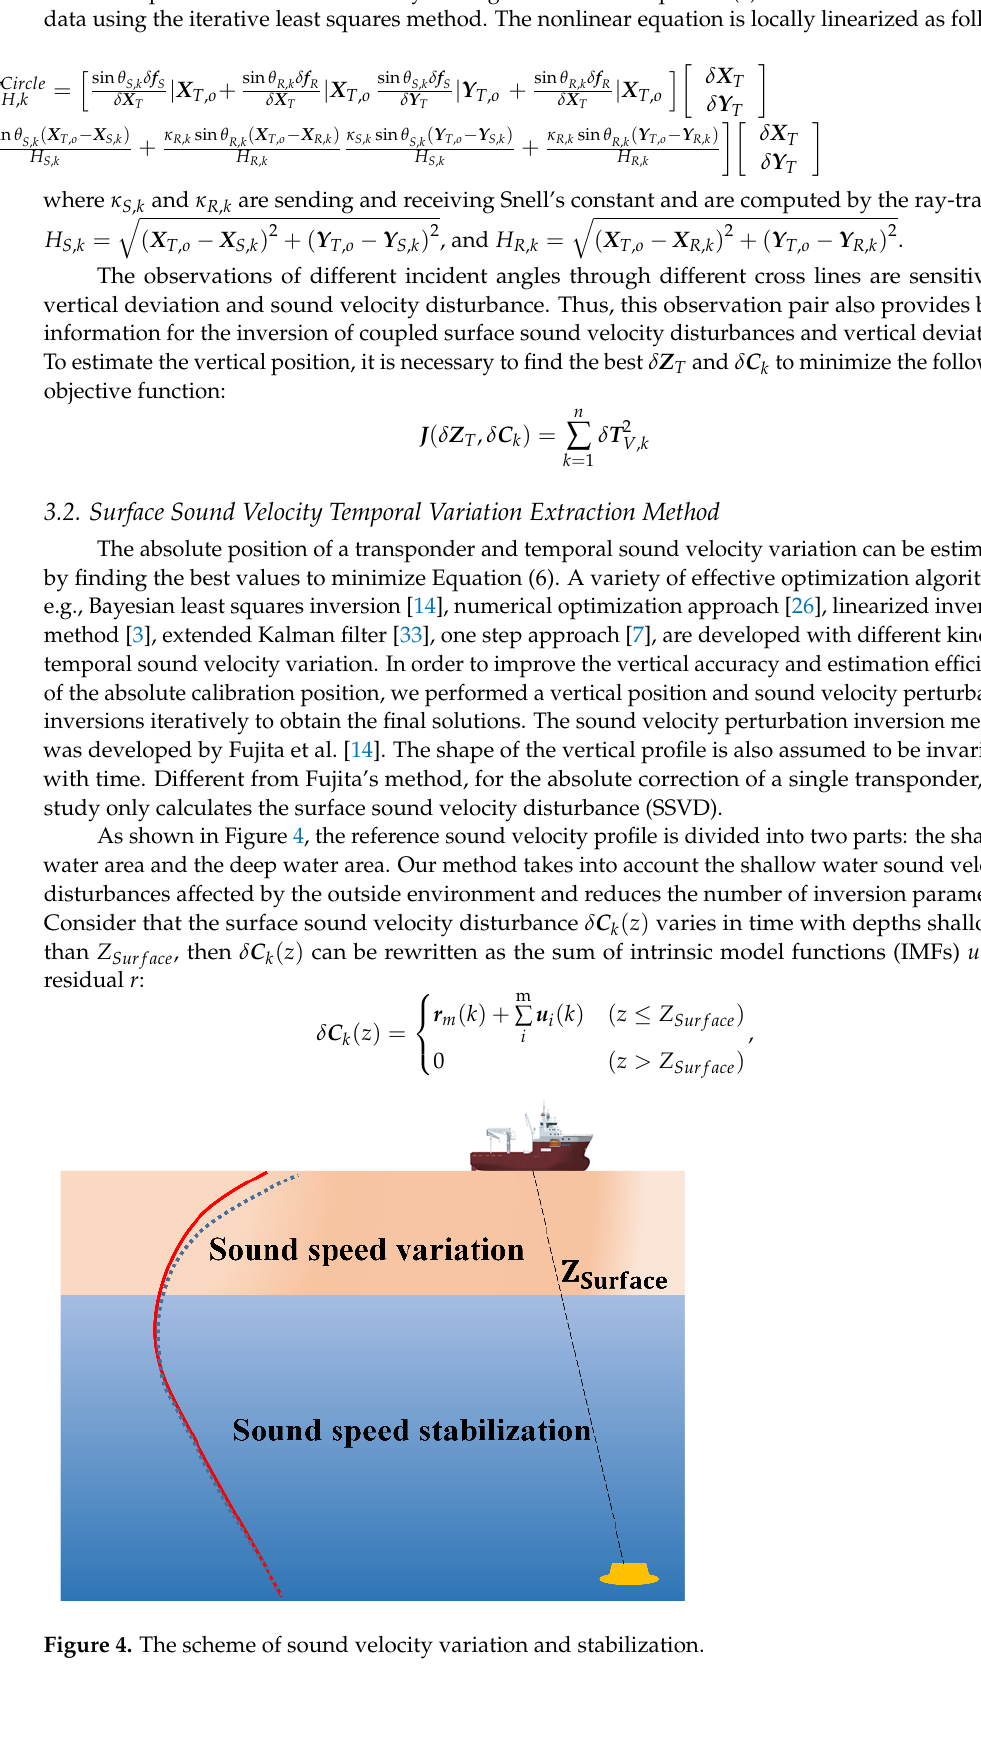
( ) z δ C based on vertically normalized k δ C is calculated using the